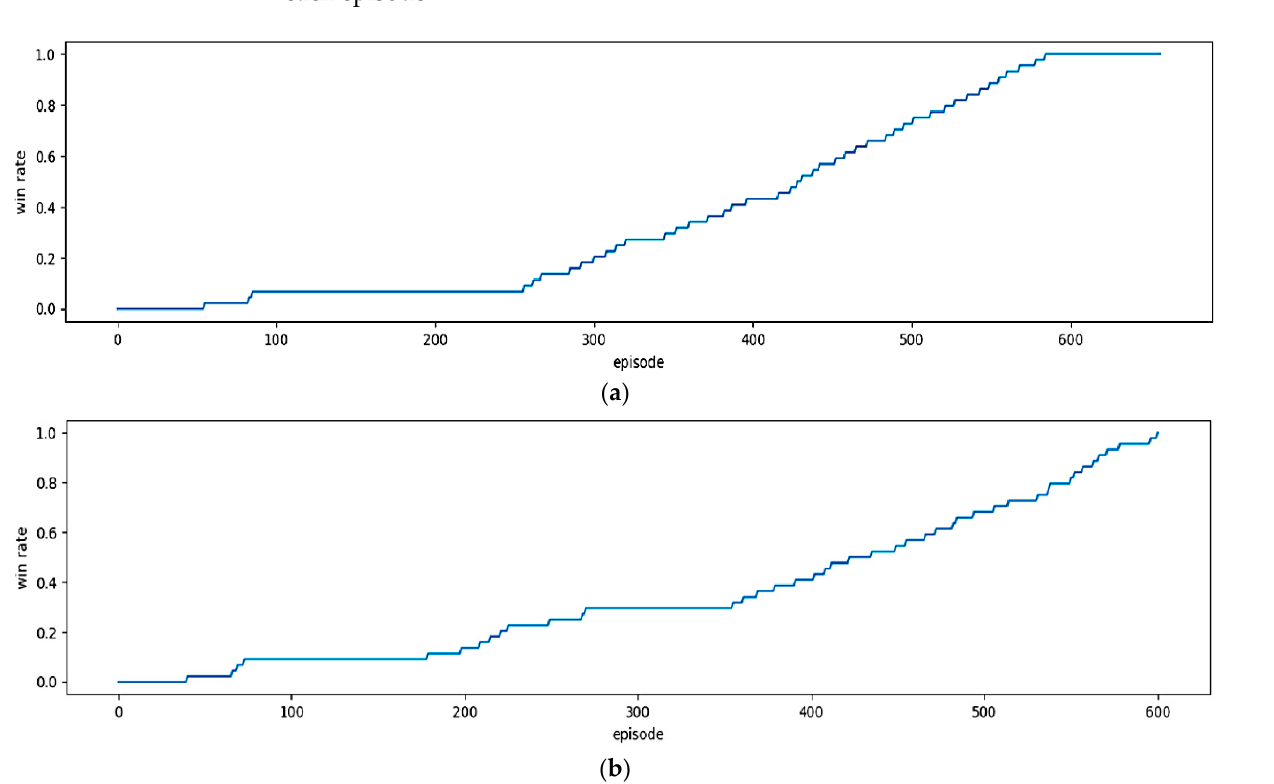
Figure 9. The comparison of Win rates when training the DQN model with two activation types in the case of the 8 × 11 grid map. ( a ) The DQN model with PReLU activation; ( b ) the DQN model with ReLU activation.